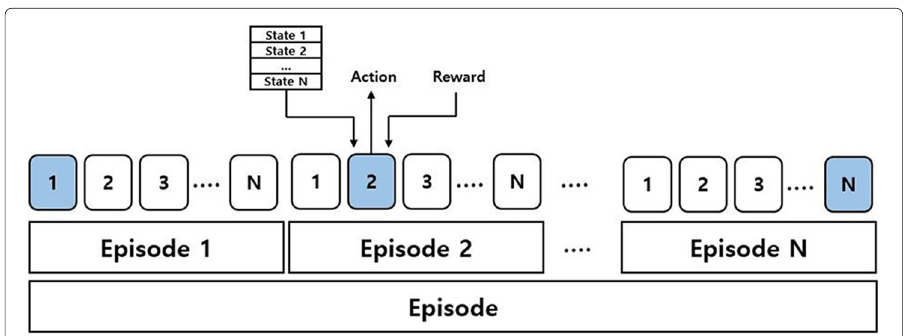
Fig. 3 Episode division by terminal node for